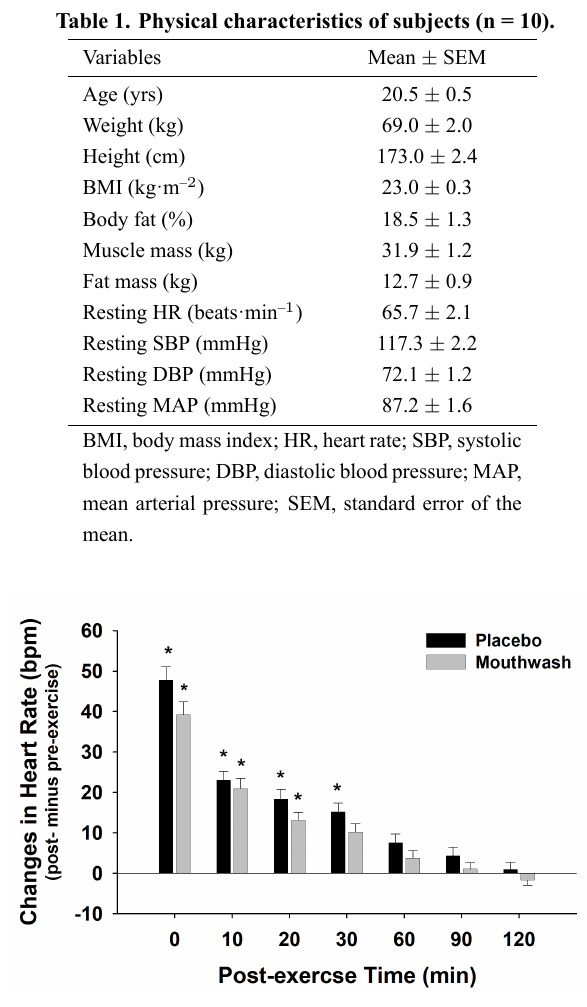
Fig. 2. Changes (post-exercise minus pre-exercise values) in heart rate during the recovery period (0 to 120 min). Values are presented as mean ± SEM. *, p < 0.05 compared with pre- exercise values. bpm, beats per